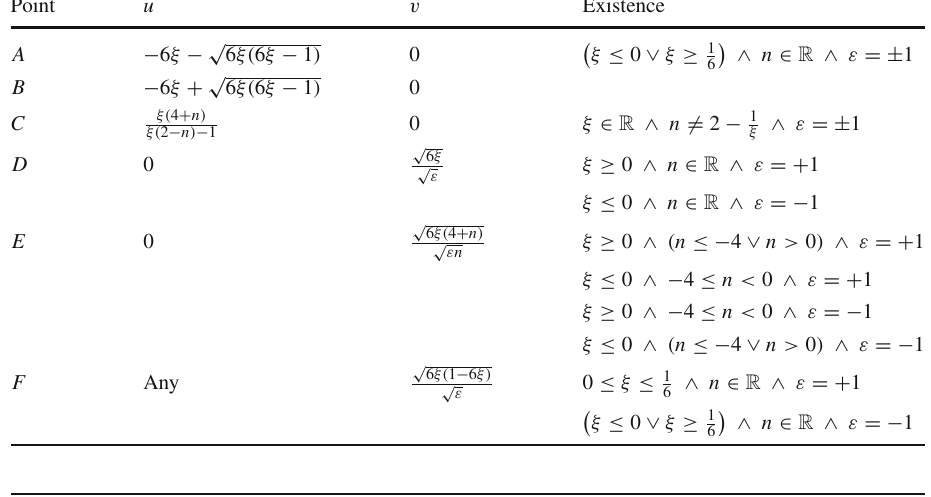
Table 2 Eigenvalues, stability type, equation of state parameter w φ value and the condition for the w φ = − 1 for equilibria of system (25)